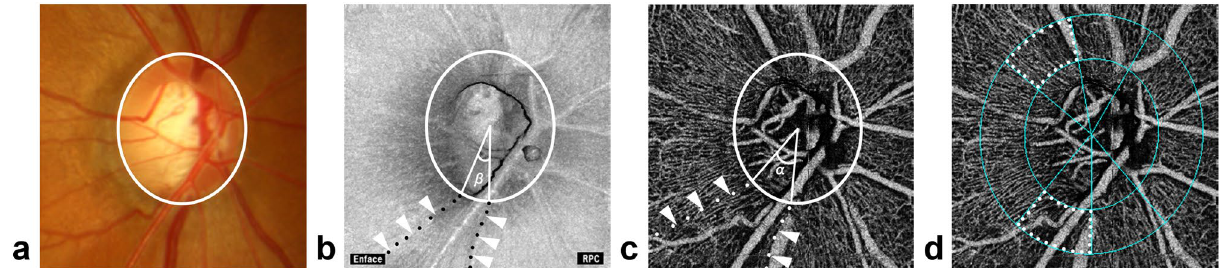
Figure 1. Measurements of NFLD-angle, VD, and deMv-angle. ( a ) Disc photograph. The white circle indicates the boundary of the optic disc. ( b ) NFLD-angle (β) is determined in the OCT en face image. RPC = Radial peripapillary capillary. ( c ) deMv-angle (α) is determined in the superficial OCTA image. ( d ) VD is assessed in the superficial OCTA